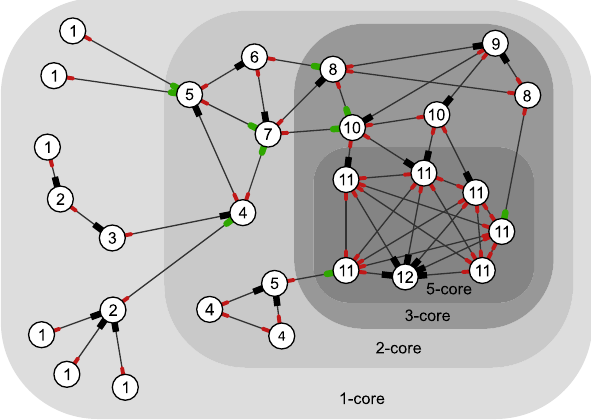
FIG. 1. Illustration of the onion decomposition (OD) of a simple network. The number of the layer to which each node belongs is indicated and the different k -cores are shown using increasingly darker background shades. The color of each stub according to the LCCM is also shown (different sizes and shapes are used for a clearer contrast between the three types of